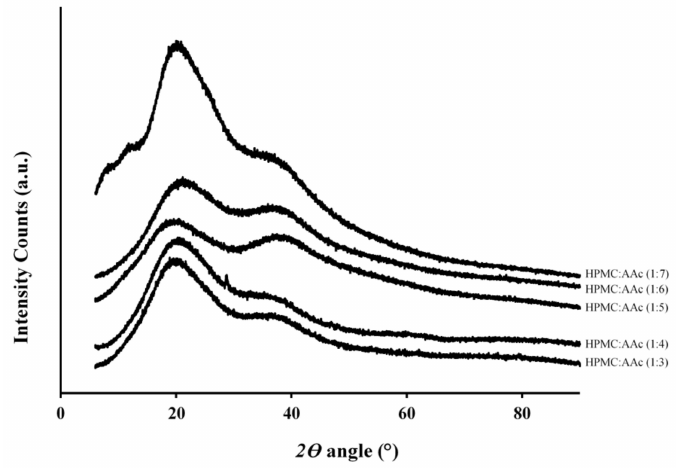
Figure 2. X-ray diffractograms of HPMC:AAc systems (1:3, 1:4, 1:5, 1:6,